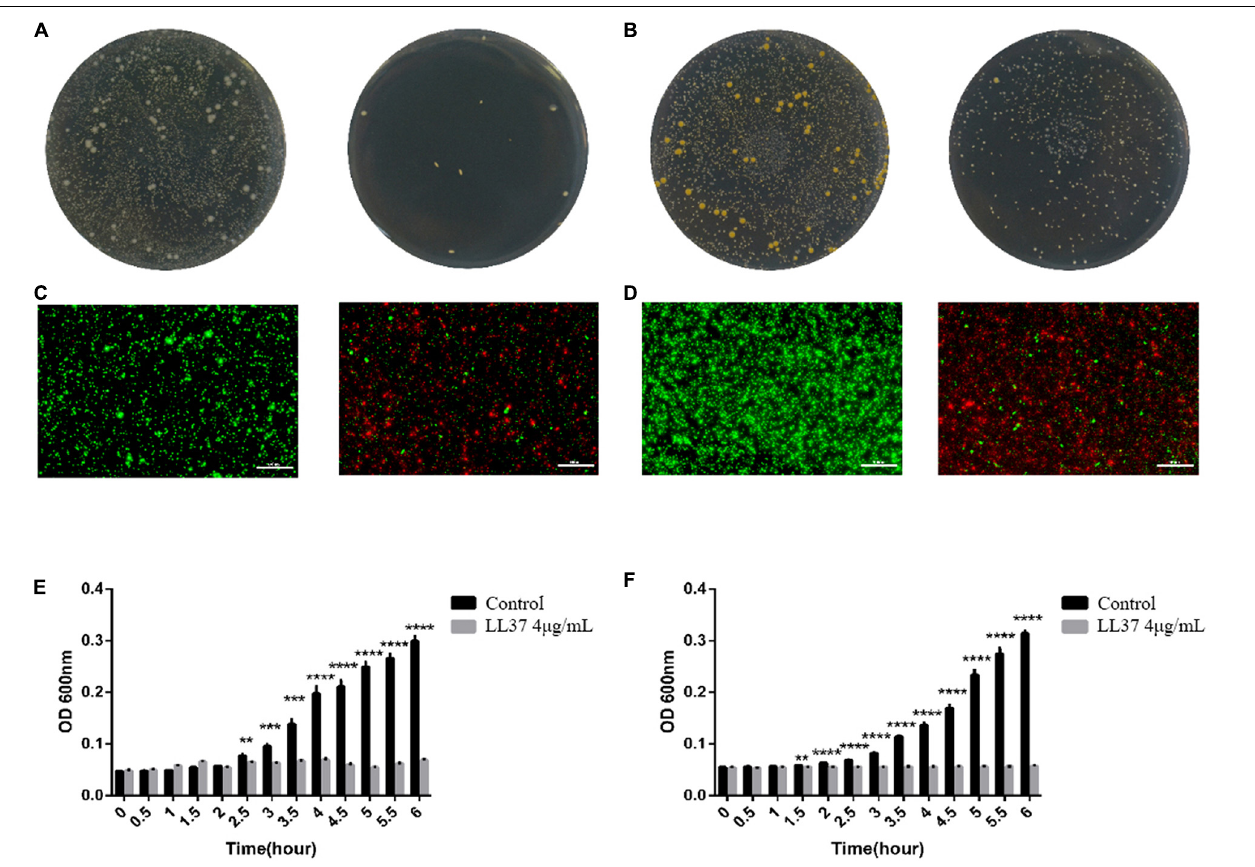
FIGURE 3 | Antibacterial effects and inactivity efficiency of 4 µ g/mL of LL37 against E. coli and S. aureus. 10 4 CFU bacteria were cultured in 4 µ g/mL of LL37 and PBS of the same volume (control group) for 6 h. (A) Gross antibacterial results showed the colony number of E. coli treated with LL37 was significantly smaller than that of the control group. (B) Gross antibacterial results indicated that the colony number of S. aureus treated with LL37 was significantly smaller than that of the control group. (C) The results showed that the number of live E. coli treated with LL37 was less than that of the control group, but the number of dead bacteria was greater than that of the control group. (D) The results implied that the number of live S. aureus treated with LL37 was less than that of the control group, but the number of dead bacteria was greater than that of the control group. (E) The OD600 nm value of bacteria treated by LL37 and PBS (control) against E. coli showed a significant difference between the LL37 group and the control group after 2.5 h. The OD value of the LL37 group did not fluctuate significantly within 6 h which proved that the activity of bacteria was significantly affected. The bacterial proliferation of the LL37 group was at a standstill whilst bacterial proliferation was obvious in the control group. (F) Tracing OD600 nm value of bacteria treated by LL37 and PBS (control) against S. aureus showed a significant difference between the LL37 group and the control group after 1.5 h. The OD value of the LL37 group did not fluctuate significantly within 6 h, which proved that the activity of bacteria was significantly affected. The bacterial proliferation of the LL37 group was at a standstill, while the bacterial proliferation was obvious in the control group. The scale bar is 100 µ m ( n = 3, unpaired t -test, ** p < 0.005, *** p < 0.0005, **** p <